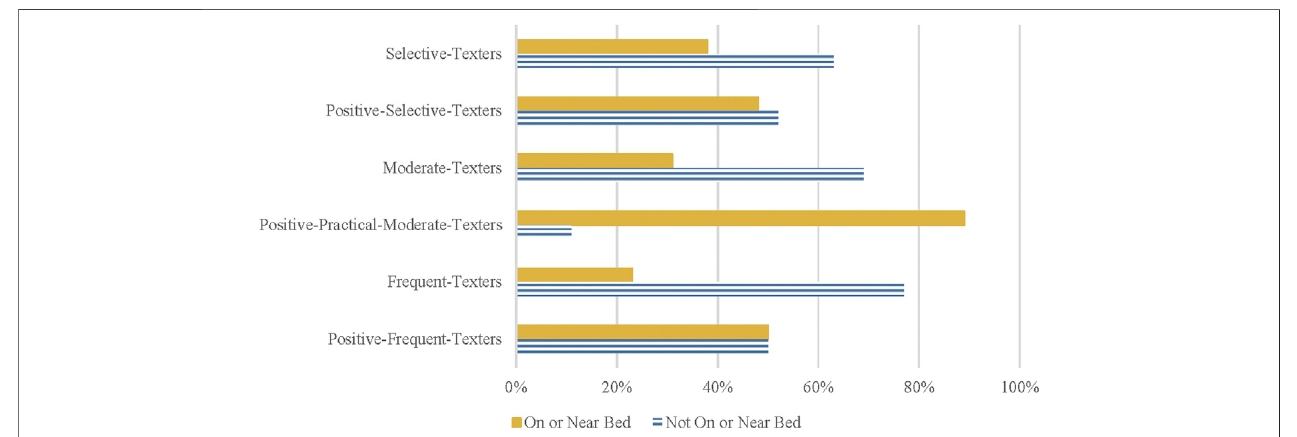
FIGURE 2 | Cell phone location during